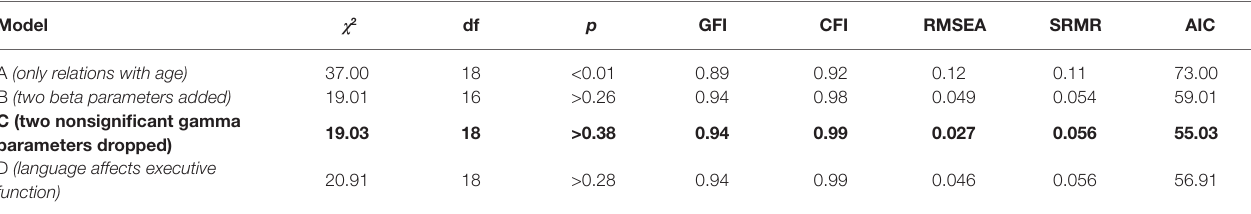
TABLE 9 | Goodness of fit indices for the alternative models of structural relations among language, drawing, general executive functioning, and age. Model χ 2 df p GFI CFI RMSEA SRMR AIC